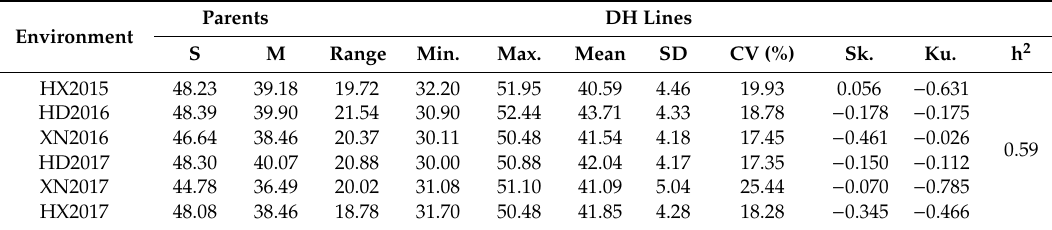
Table 2. Value of thousand-grain weight (TGW) (g) trait in parents and the doubled haploid (DH) lines across all